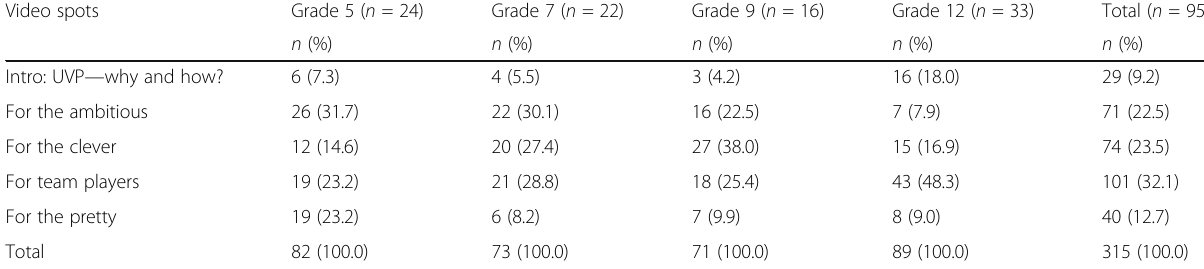
Table 5 Identification of students with videos indicated by frequencies of adhered dots by grade ( n = 95) Video spots Grade 5 ( n = 24) Grade 7 ( n =